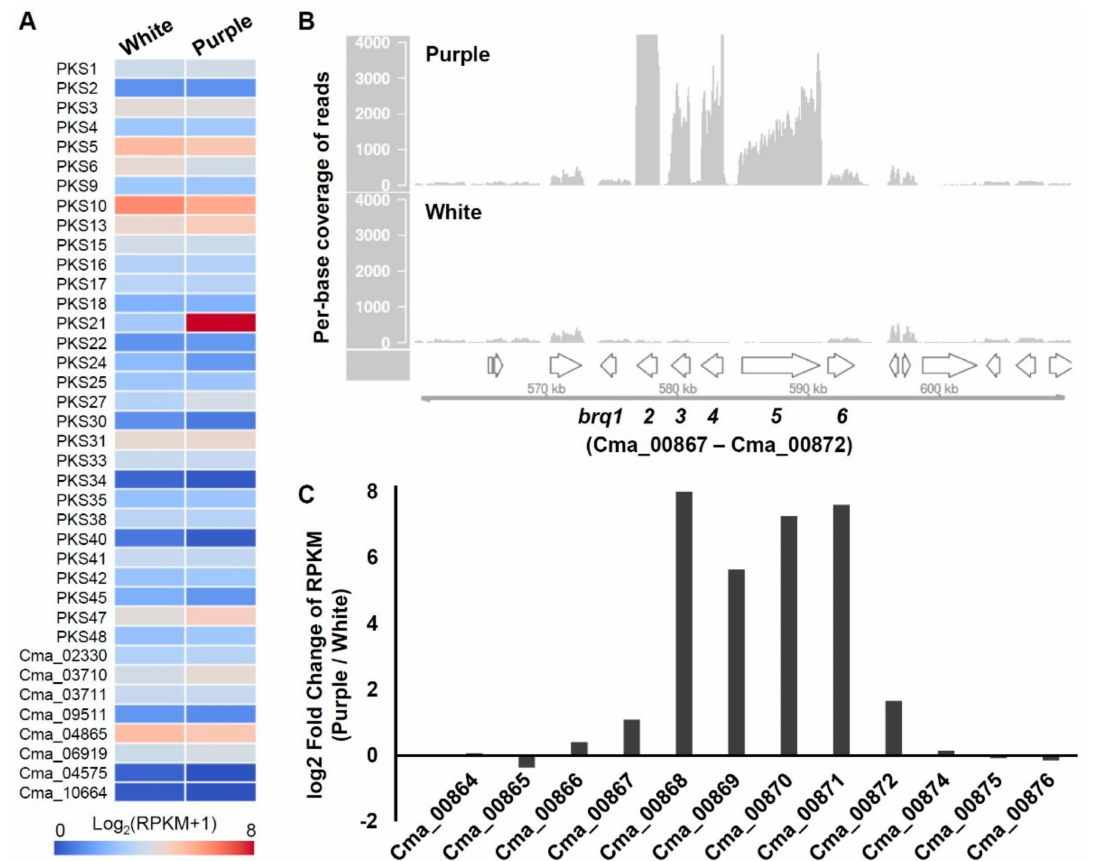
Figure 3. Identification of biruloquinone PKS and associated biosynthetic gene cluster. ( A ) Expression values (Log 2 - transformed (RPKM+1)) are shown as heat maps for 38 PKS genes in a LFF that lacks biruloquinone production (white) and a LFF that produces biruloquinone (purple) in axenic culture. ( B ) Per-base coverage of RNA-seq reads was plotted for a genomic locus surrounding the PKS21 ( brq5 ; gene ID: Cma_00871). RNA-seq reads mapped on the C. macilenta reference genome were subsampled to 60 million reads for visual comparison of expression levels between white (lower panel) and purple (upper panel). Arrows on the x -axis indicate genes (brq1 – brg6 ) and flanking genes. The numbers on the y -axis are per-base coverage. ( C ) Log2-transformed fold change of RPKM values in purple compared to white. RPKM, reads per kilobase per million mapped